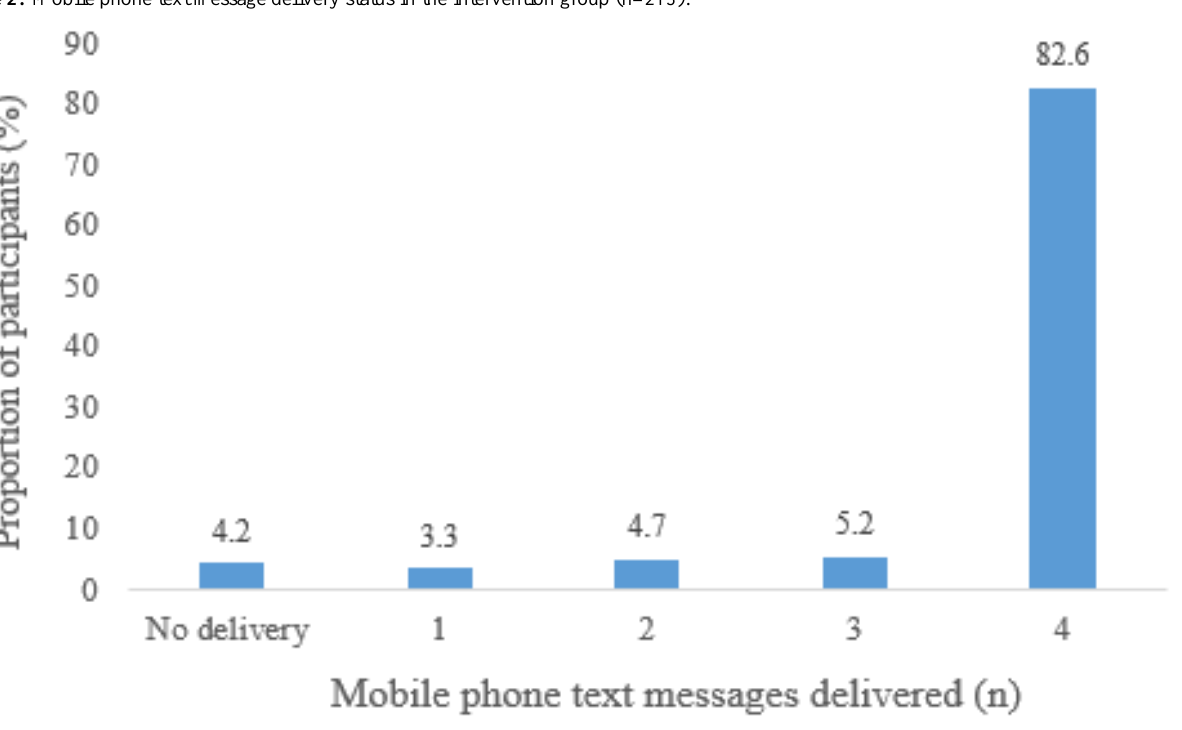
Figure 2. Mobile phone text message delivery status in the intervention group